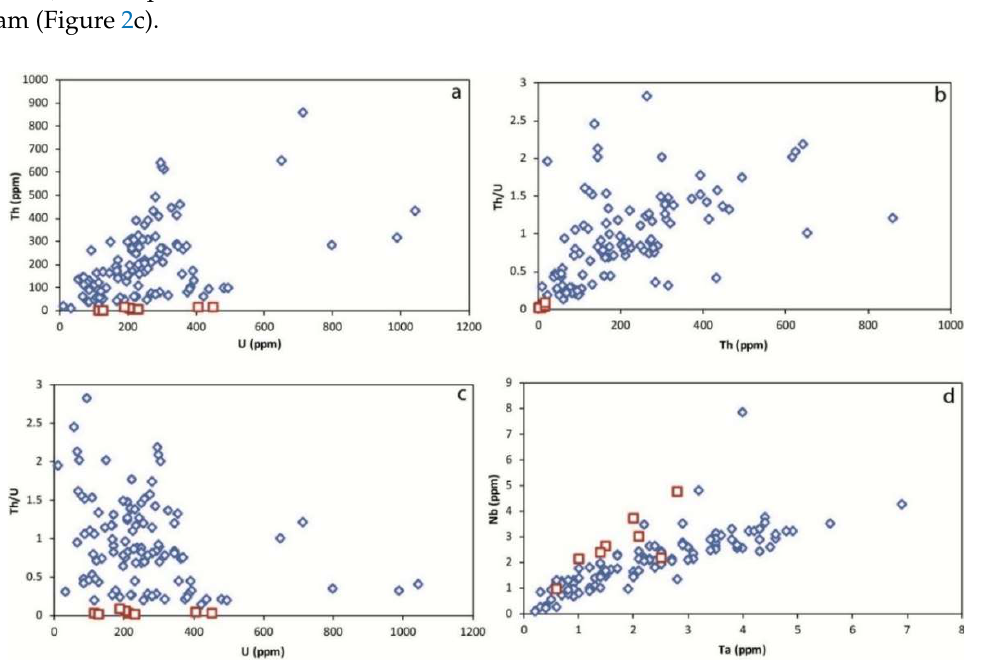
Figure 2. Geochemical correlation of various elements/ratios within the western Meiganga detrital zircons ( a ): Th versus U; ( b ): Th/U versus Th; ( c ): Th/U versus U; ( d ) Nb versus Ta; blue and white diamond-shape plots are for magmatic zircons; red and white square plots are for metamorphic zircon). The lead content ranges from 1.0 to 713 ppm. The lowest values were obtained in MW052, MW058, and MW065, and the highest in MW095 and MW114. It is noted that some zircons with very low Pb value also have very low Th, with similar Th (Th = 8 ppm: MW015) and Pb (Pb = 8 ppm: MW015) being found in the same grain. Some grains have the same Pb content (e.g., Pb = 149 ppm: MW018 and